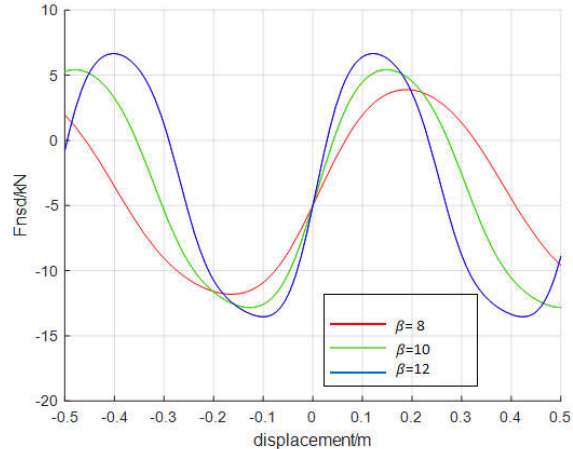
Figure 8. Force–displacement curve under different β